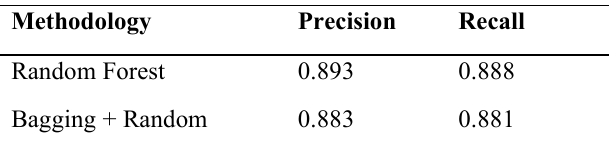
Table 4. Precision and Recall comparison of various